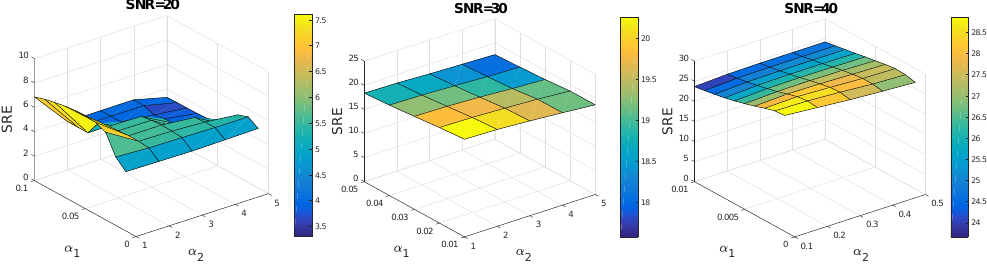
Figure 7. SRE (dB) as a function of parameters α 1 and α 2 for DC1 with different SNR levels. From left to right: SNR = 20 dB, β = 1; SNR = 30 dB, β = 0.5; and SNR = 40 dB, β =